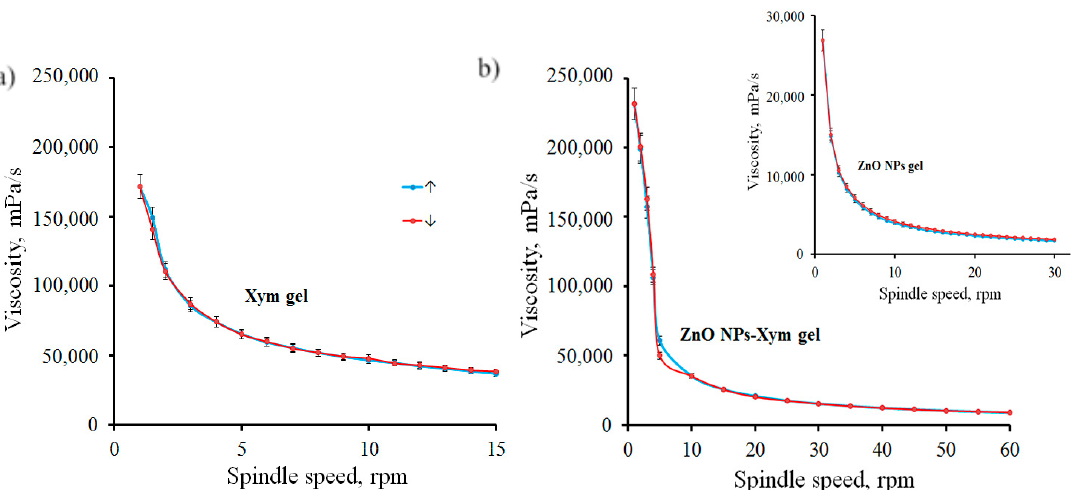
Figure 5. Structural viscosity as a function of spindle speed for Xym (5%) gel ( a ) and ZnO NPs (0.05%)–Xym (2.5%) gel ( b ). The insert shows structural viscosity as a function of spindle speed for ZnO NPs (0.1%) gel. Blue lines correspond to compression and yellow-orange lines correspond to stretch.